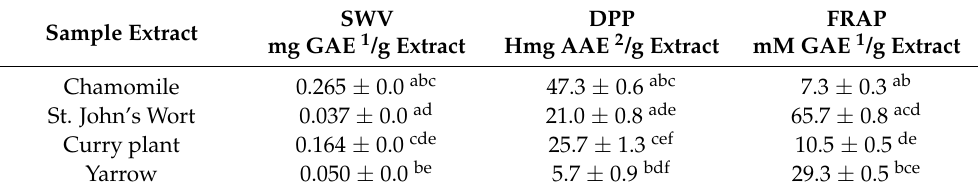
Table 4. Antioxidant activities in extracts obtained using supercritical CO 2 extraction from four medicinal plants measured by three antioxidant assays (SWV, DPPH, and FRAP). Results are pre- sented as mean value ± standard deviation ( n =